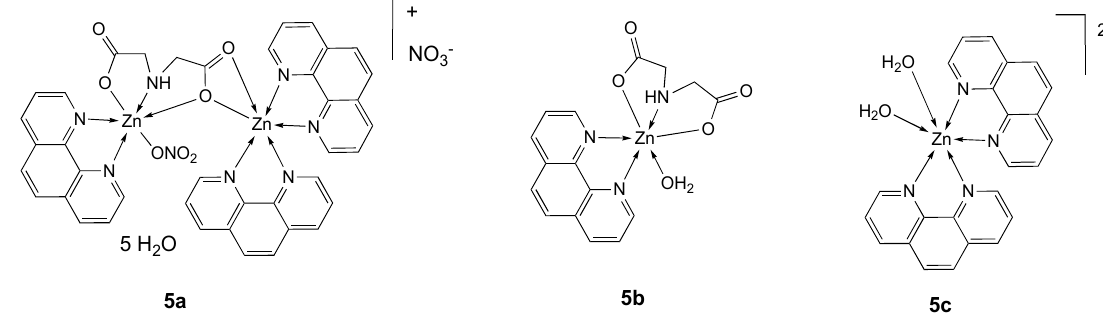
Table 2. IC 50 values (µM) for zinc complexes 4 – 7 , free ligands phen, ida, bpy and Hnor and the reference compounds cisplatin, ZnCl 2 and ZnSO 4 against different tumor and normal (LO 2 and PBMC) cell lines, after an incubation time of 48 h.